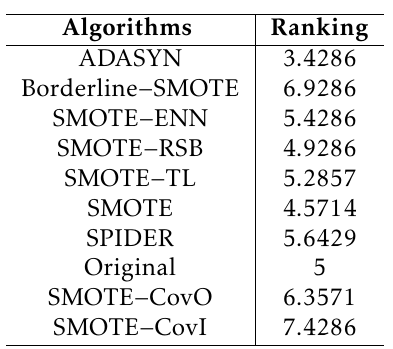
Table 3. Friedman’s Test